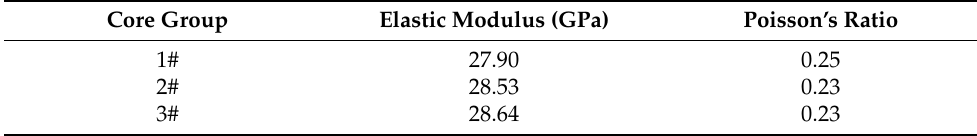
Table 3. In-situ stress test results.